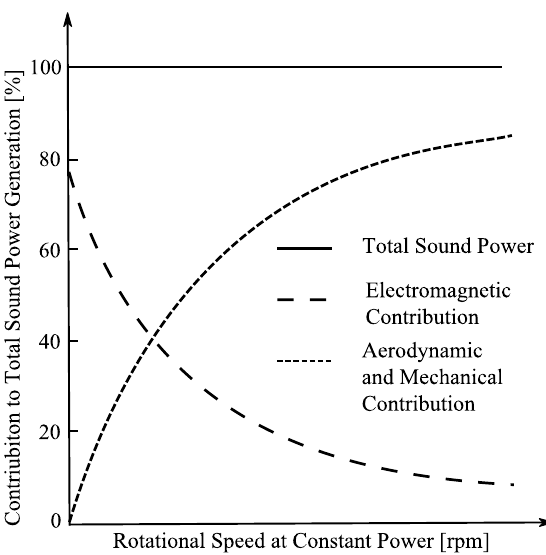
Figure 1. Contributions of different sources to sound power radiation [1].